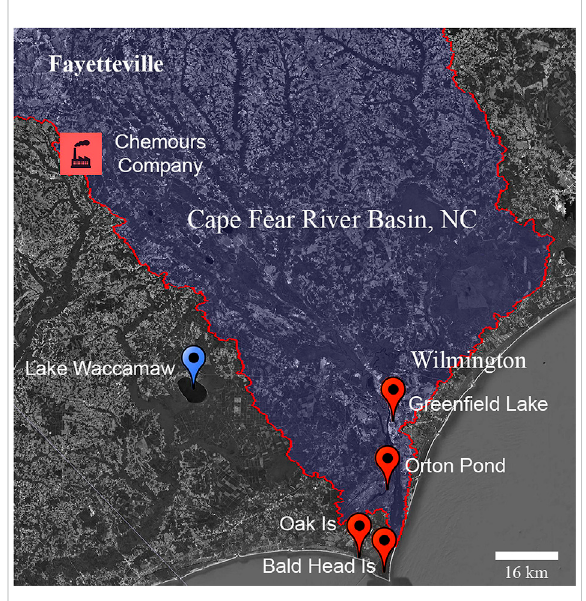
FIGURE 1 Location of study sites in South Eastern North Carolina. Location of alligator sampling sites at Lake Waccamaw (blue) and from the Cape Fear River (orange). The location of known upstream fl uorochemical production discharge is